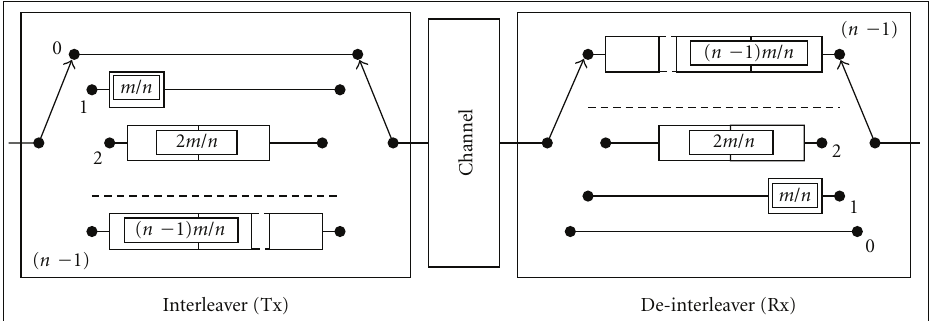
Figure 6: n × m convolutional interleaver/deinterleaver.